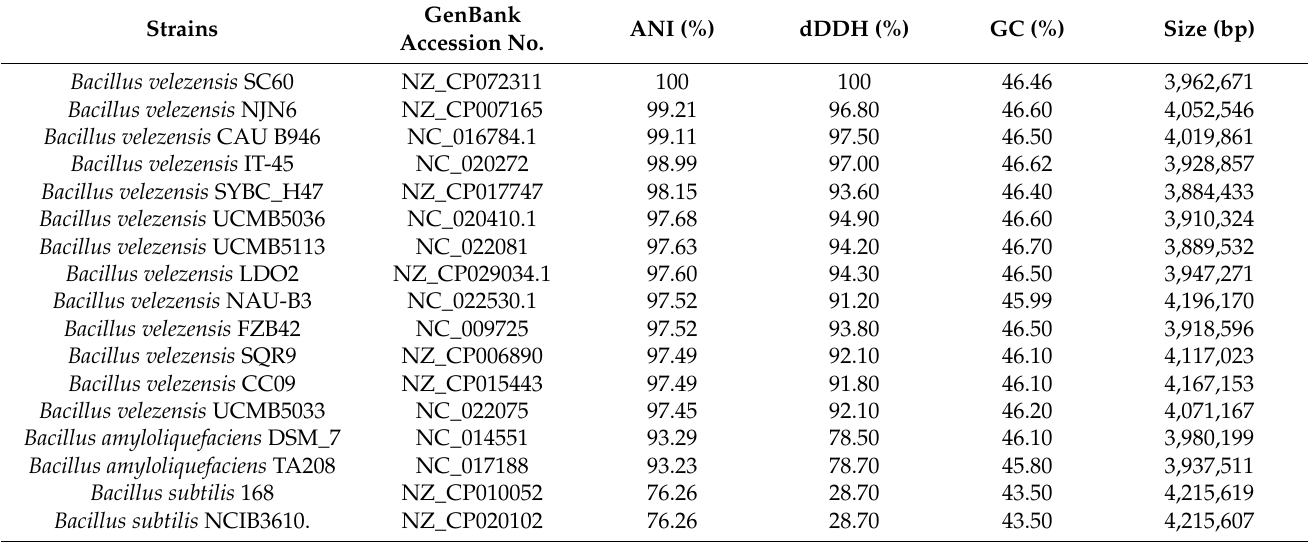
Table 2. Comparative genomic analysis of Bacillus velezensis SC60 with Bacillus